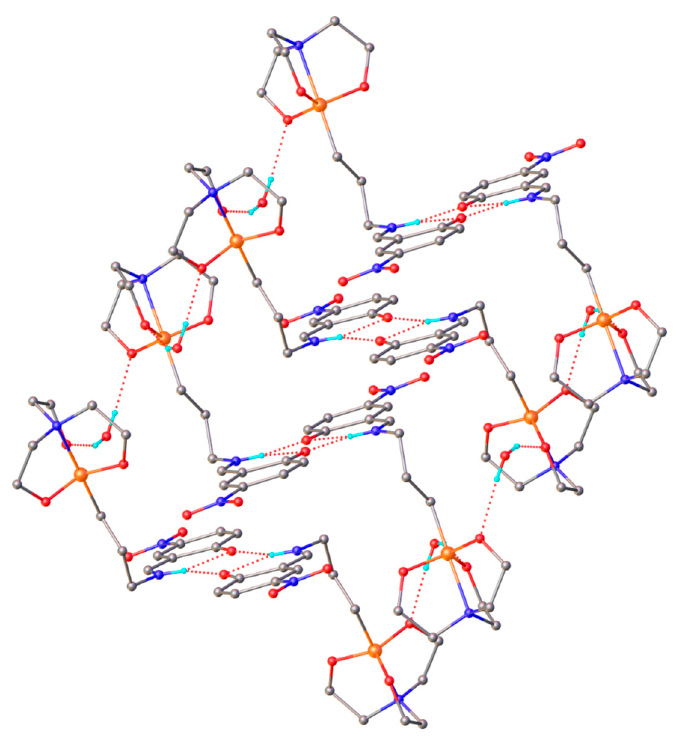
Figure 2. 1D supramolecular chain in the crystal structure of SIL-BS formed by intermolecular hydrogen bonds N-H···O and O-H···O. Table 2. Crystal data and details of data collection for SIL-BS.